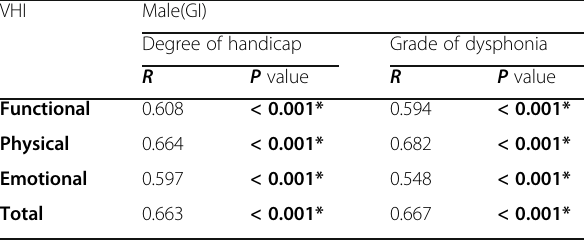
Table 9 Correlation between VHI and grade of dysphonia in male